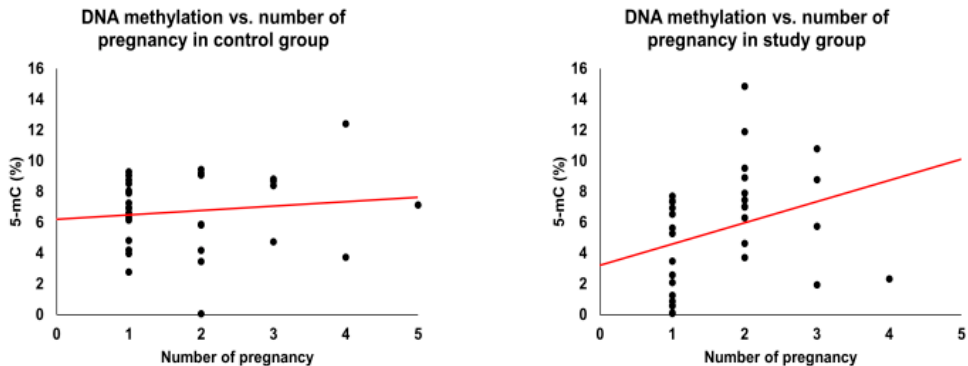
Figure 2. Global methylation level and number of pregnancies. The red line represents linear correlation.